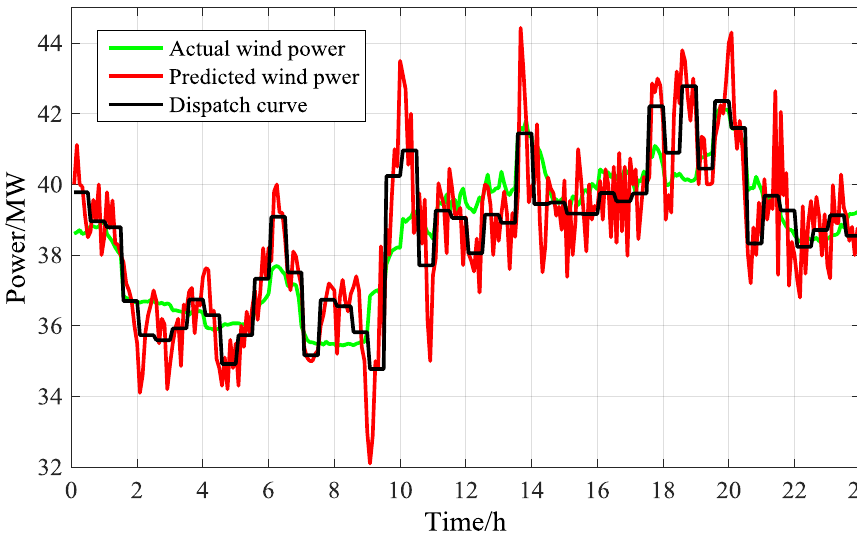
Figure 4. Wind power and dispatching curve.